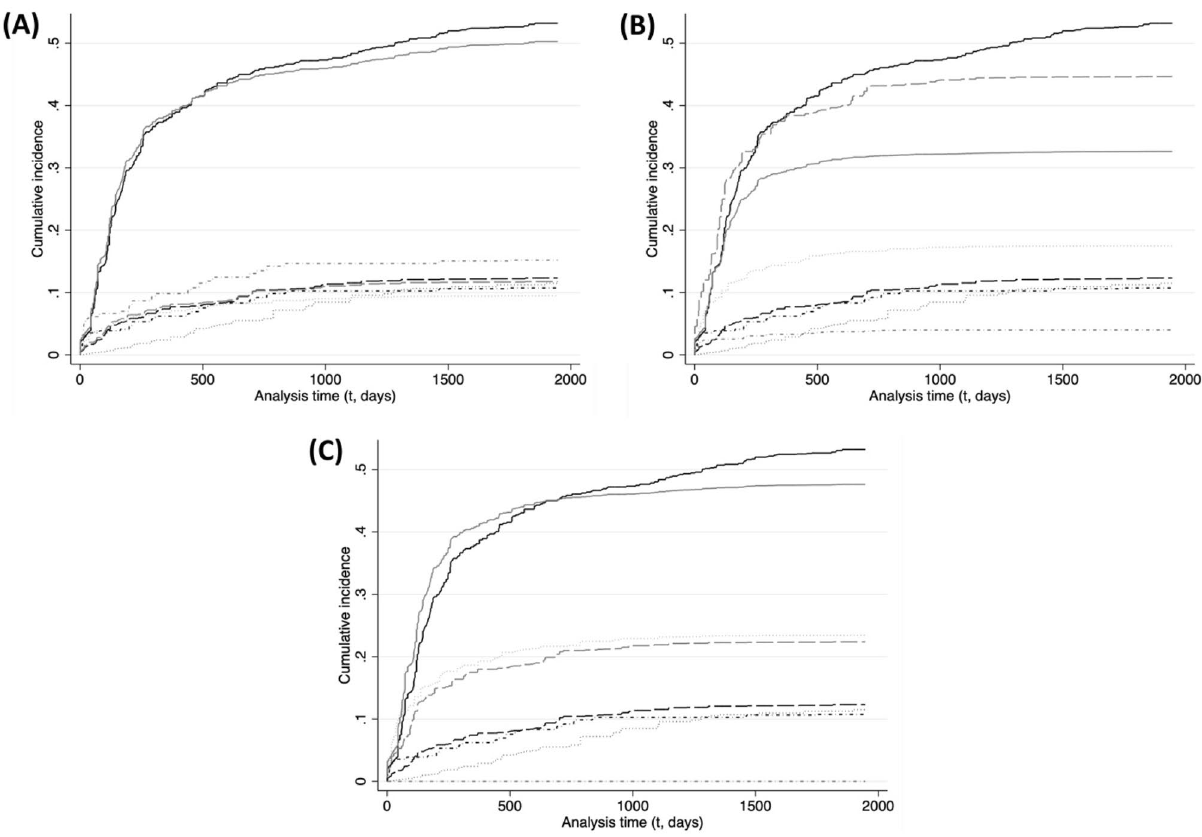
Figure 2. Endpoint-specific cumulative incidence curves (CIFs) over monitoring time (in days) constructing using all endpoint hazards obtained from our preferred joint stratified Cox model (Model 3, Table 1) for n = 495 adult monitored wolves in Wisconsin, USA (1979–2012). Each panel corresponds to a season (( A ) hunt/ hound , ( B ) hunt/hound/snow , ( C ) snow ) and illustrates the baseline (black curves) and seasonal (gray curves) cumulative incidences for our endpoints of interest: LTF (solid), reported poached (longdash), legal killing (dash-dot) and natural